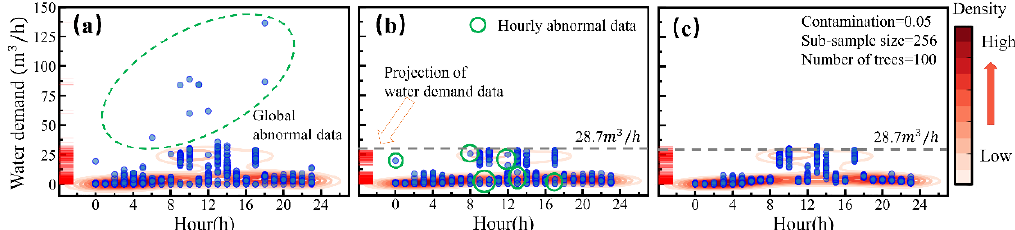
Figure 3. Scatter and density contour map of ( a ) the observed water demand; ( b ) the results of global outlier detection and correction; ( c ) the results of local outlier detection and correction. Blue scatters represent the hourly water demand data in different hours. The right color bar shows the density contour map for water demand data. Red lines near the y-axis are the projections of water demand data.